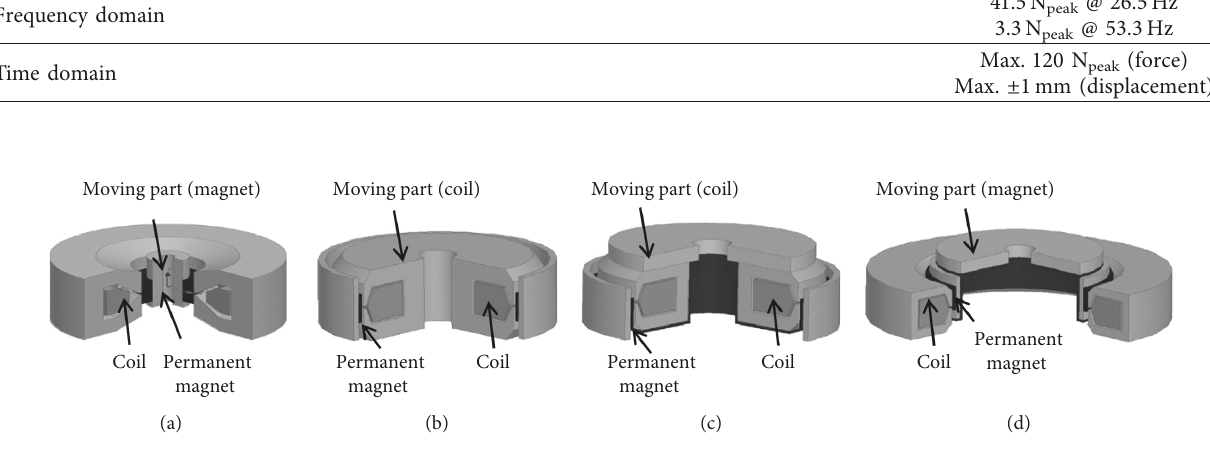
Figure 3: Design of electromagnetic actuator. (a) 1 st concept design. (b) 2 nd concept design. (c) Detailed design-I. (d) Detailed design-II.